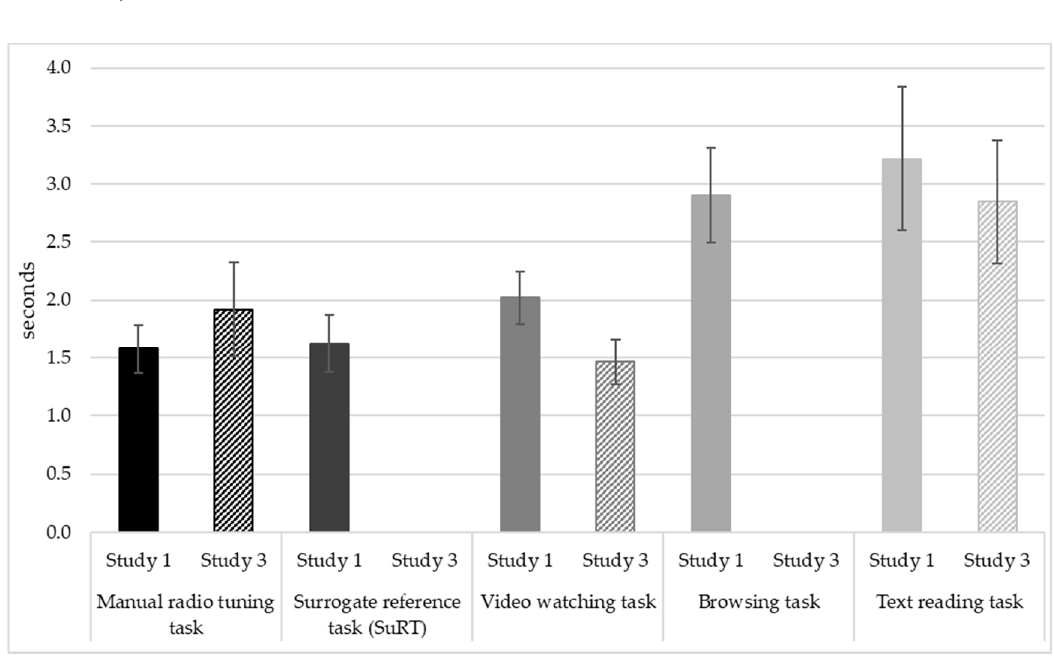
Table 5. Effects of the parameters used to examine take-over capabilities across the three studies.